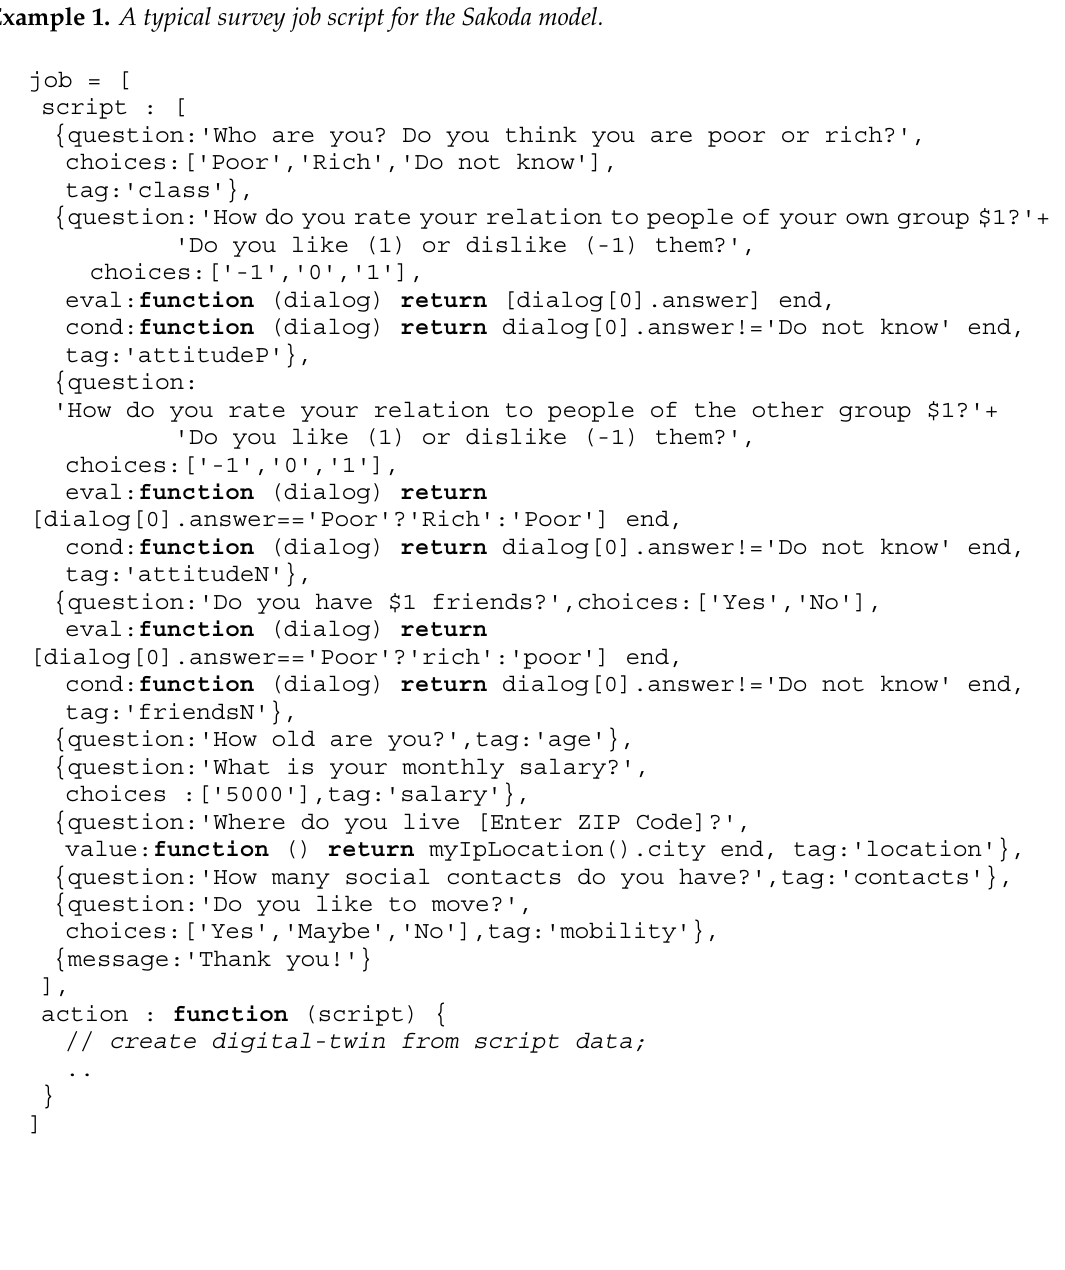
Figure 10. Simulation world with long-term mobility, without spatial and context constraints at different simulation times (500/1000/1500 steps) consisting of 200/200 a/b class agents (blue/red squares) all with S = (1,-1,-1,1) and r = 3 parameter settings and additionally up to 200 digital twins (triangles with colour based on individual S/r parameters).